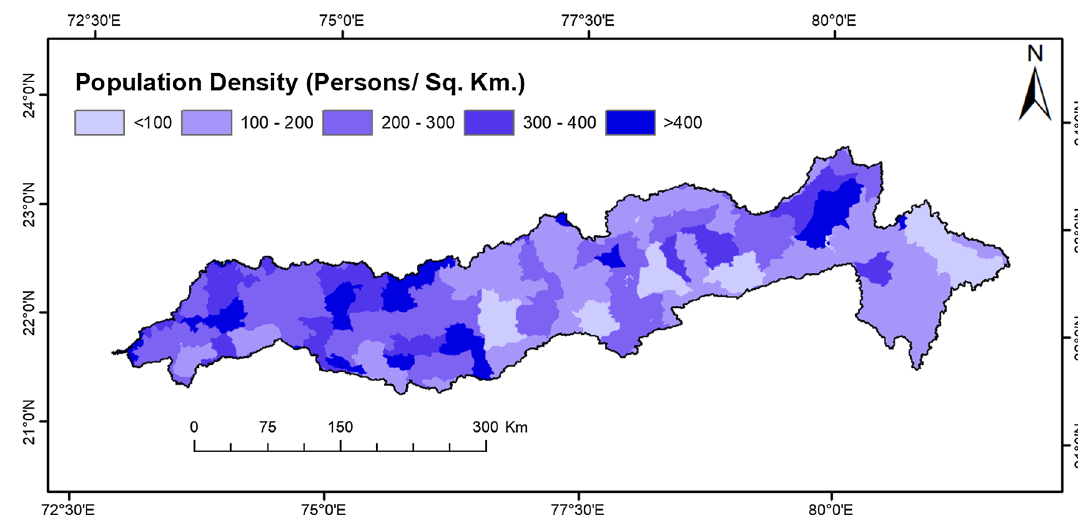
Fig. 6 Spatial distribution of population density over Narmada River Basin